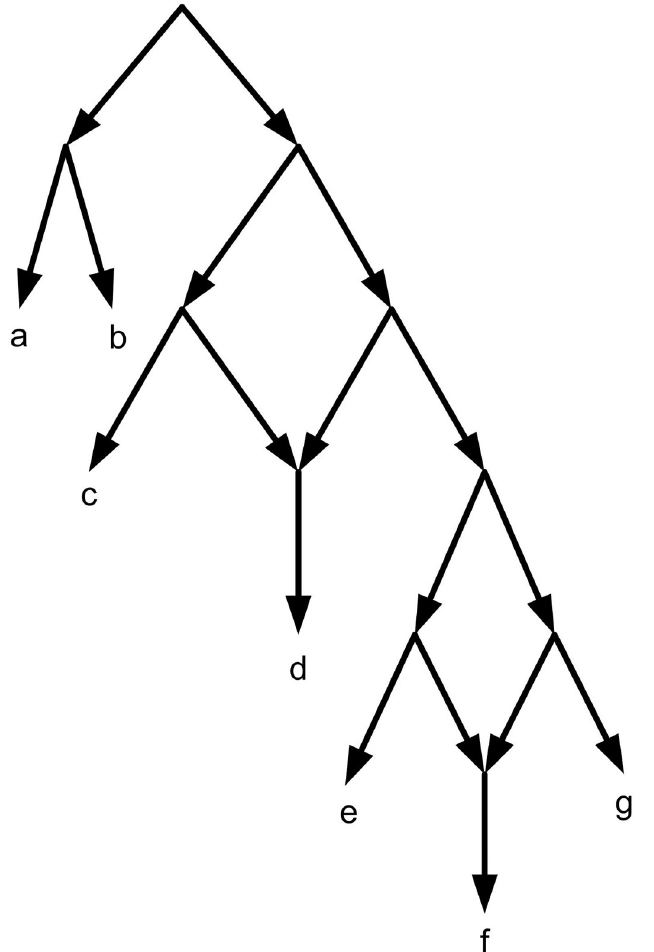
Fig 7. A level-1 network (galled tree) with two reticulation